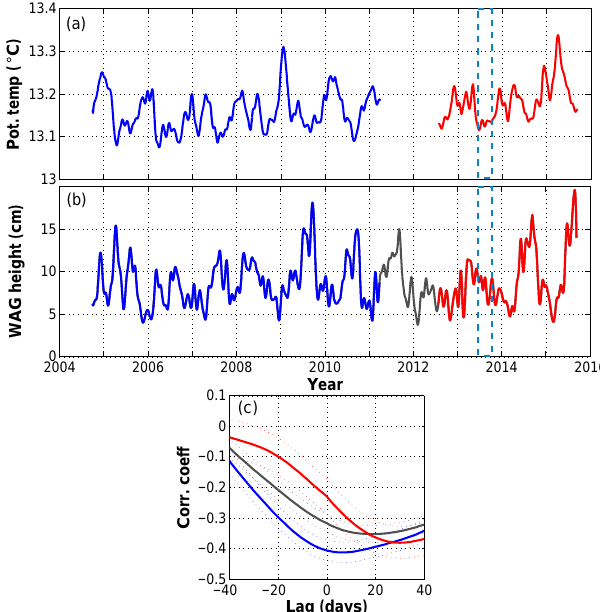
−0.3−0.2−0.100.1 40−0.5−0.4 −40 −20 0 20 Lag (days) Figure 6. (a) Low-passed series (21 − 1 cpd cut-off frequency) of the potential temperature corresponding to the maximum density samples observed each semi-diurnal tidal cycle at ESP. The series has been coloured in blue and red before and after the gap of years 2011–2012, respectively. (b) Low-passed series (same filter as in a ) of the WAG height, the proxy used to characterize its strength. The same colour code has been applied to the periods of the subseries in (a) , whereas the period of the gap is shown in grey. (c) Lagged correlation ( R ) between the first (blue), second (red), and whole (black) series of WAG height and potential temperature at ESP. Dashed lines indicate the 95% confidence interval for R ; positive lags mean that the first series (height of the WAG) leads the second one (potential temperature). The 3-month period when the sampling at CS took place is indicated by the blue dashed